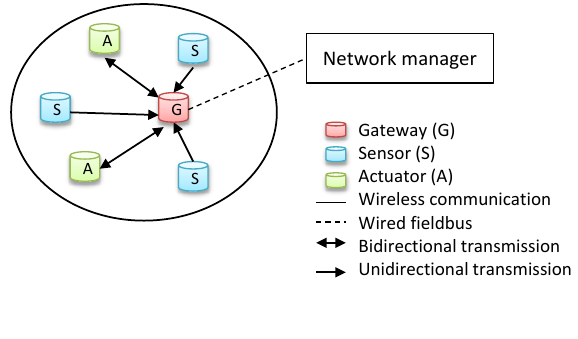
Figure 10. 802.15.4e Factory Automation MAC Layer network